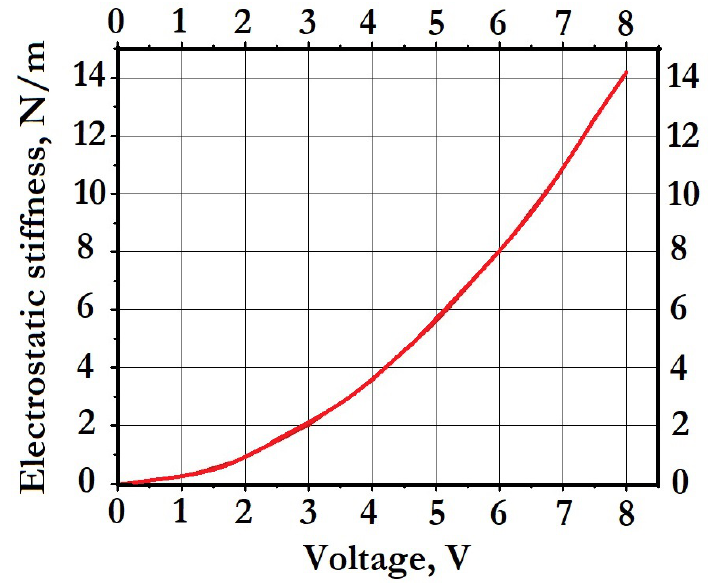
Figure 11. Graph of the dependence of the electrostatic stiffness on the applied voltage.